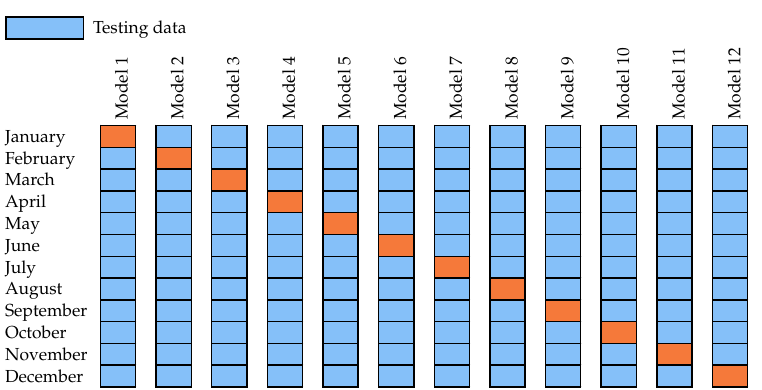
Figure 5. Splitting of the data in different ways to train and test several models. Model 1 is trained on January data and tested on the other 11 months,